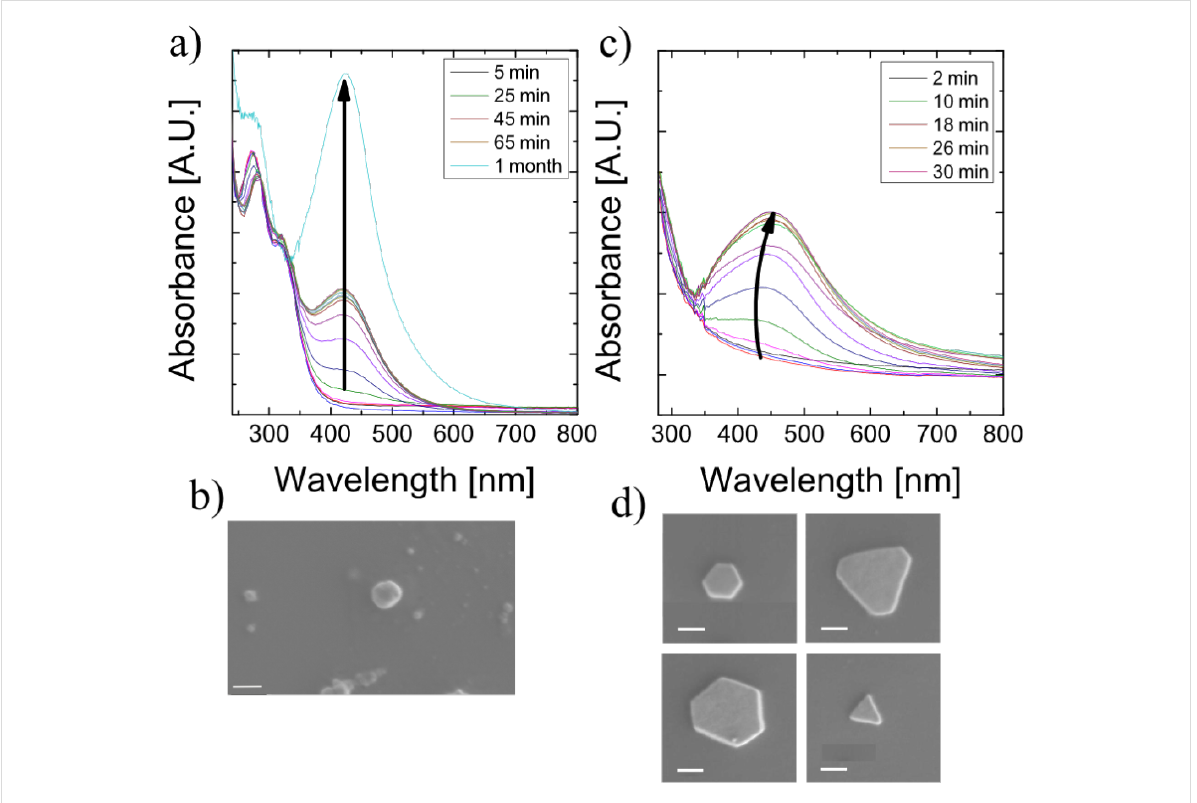
Figure 1: Time evolvement of UV–vis spectra of ≈ 1:10 orange extract/AgNO 3 solution between 5 and 65 minutes after mixing and after 1 month (a) and of ≈ 1:50 pineapple extract/AgNO 3 solution between 2 and 30 minutes after mixing (c). The arrows guide the eye between the peaks of the spectra. (b) and (d) show SEM images of typical nanoparticles prepared by using oranges and pineapples, scale bar is 100 nm.